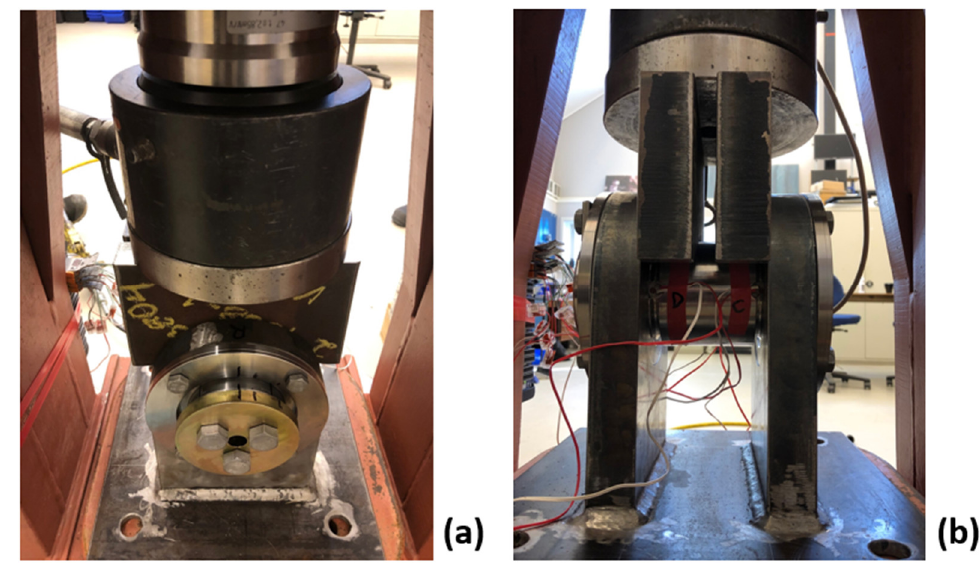
Figure 6. Test setup with ( a ) expanding pin, and ( b ) standard cylindrical pin.